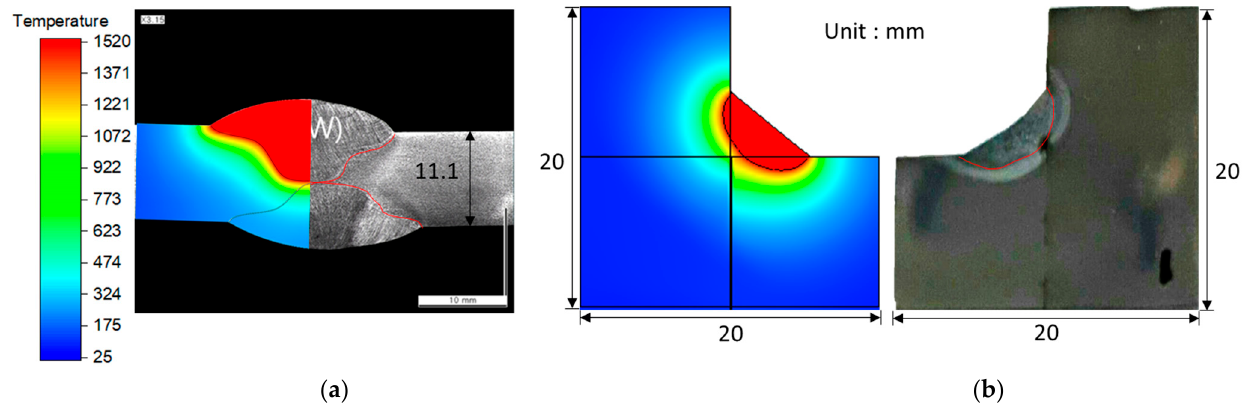
Figure 7. Comparison of weld bead morphology between the experiment and simulated result: ( a ) SAW and ( b ) GTAW.